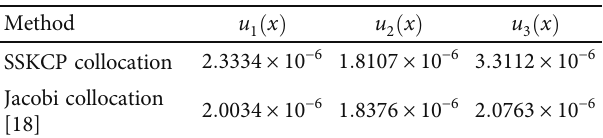
Table 3: Maximum absolute errors obtained by SSKCP collocation and Jacobi collocation methods for N = 9 , α = − 1/2 , and β = 1/2 in Example